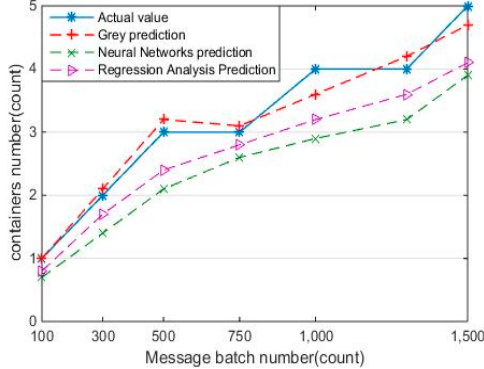
Figure 9. Actual value and predicted value.